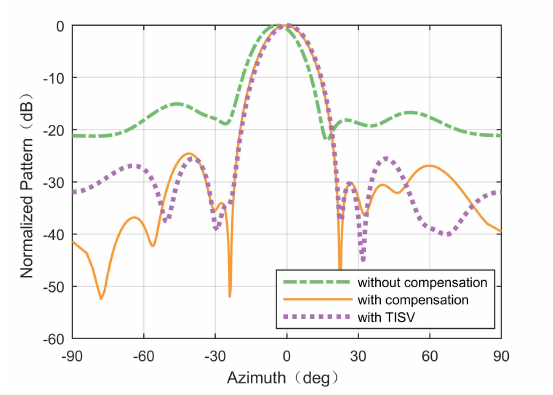
Figure 9. DoA estimation